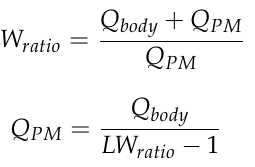
Figure 7. ( a ) Rescaled levitation force as a function of velocity and fill factor and ( b ) rescaled braking force as a function of velocity and fill factor. 3.4. Power Consumption Analysis On the basis of the results presented in Figure 7, we calculated the instantaneous power needed to overcome the magnetic braking force, as in Equation (11). As seen in the above figure, the force of magnetic braking is not only variable due to different velocities of travel but also due to the fill factor value.